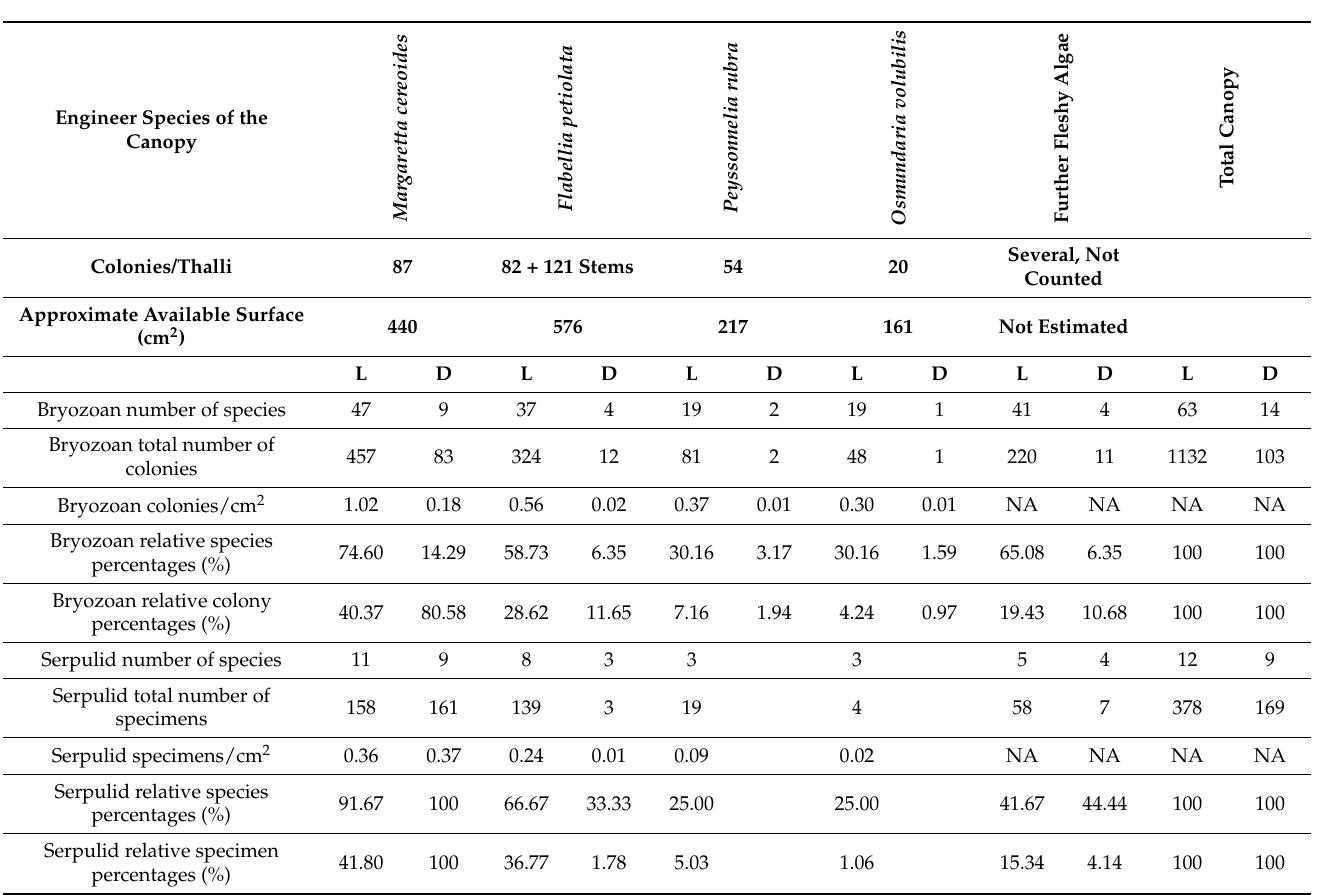
Table 1. Summary of bryozoans and serpulids found as epibionts on the engineer species of the canopy in the examined coralligenous build-up E collected offshore Marzamemi (Ionian Sea). NA: Not